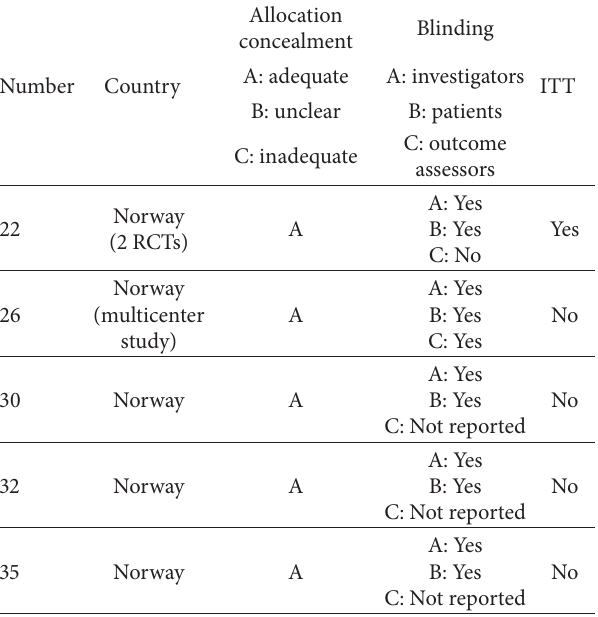
Table 3: Quality of the randomized controlled